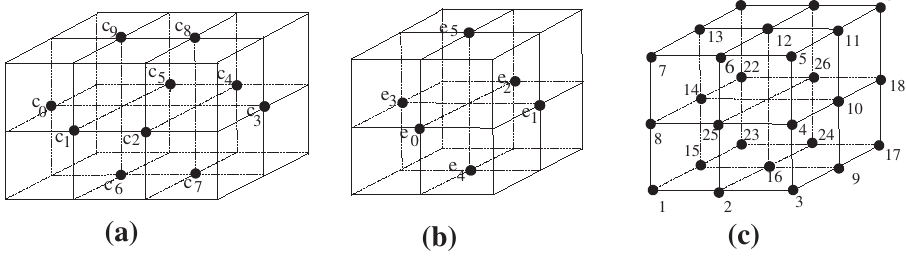
= MSS (cid:48) [5,6]; ( c ) MSS 6 26 18